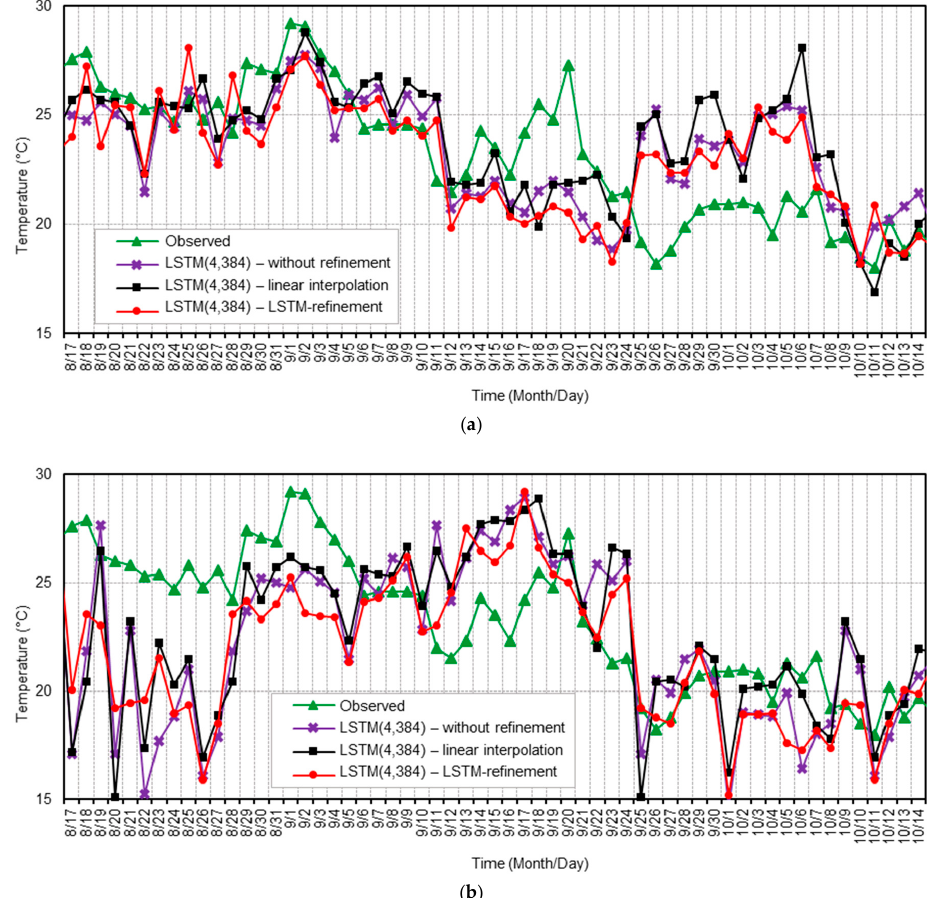
Figure 8. Daily plot of the observed and predicted temperature data for two months from August to October in Seoul, Korea for ( a ) 7 day and ( b ) 14 day prediction.